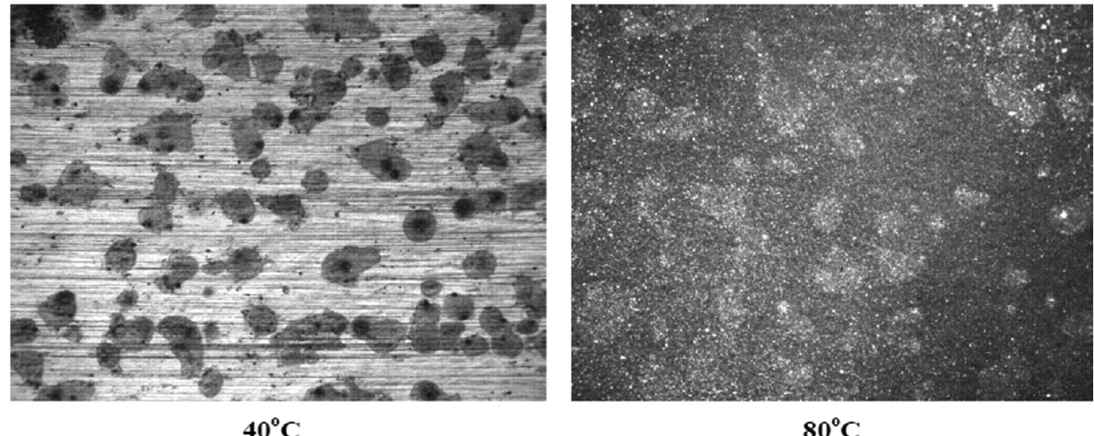
Figure 10. Optical Microscopy, at 50X, of the API X70 steel base metal surface after testing under fully immersed